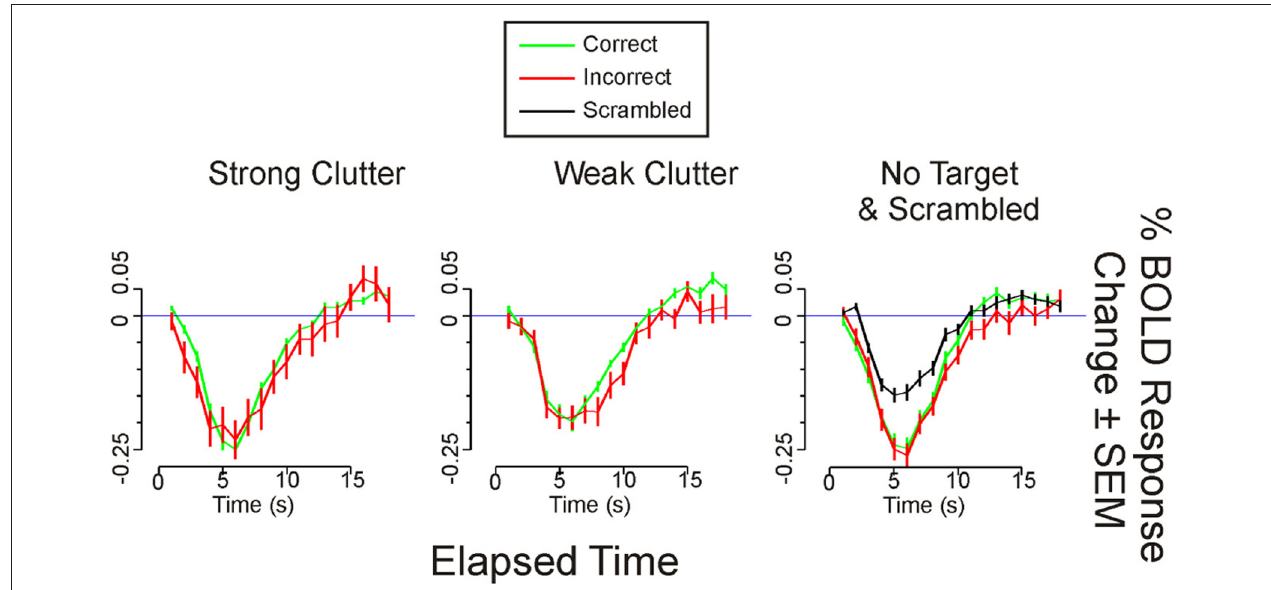
whereas during the no target condition, the correct response was a “Target Absent” report. For these three conditions, the BOLD time courses are shown separately for correct vs. incorrect responses. For the “Scrambled” condition, all subjects provided the expected response in all trials, so that incorrect responses were not